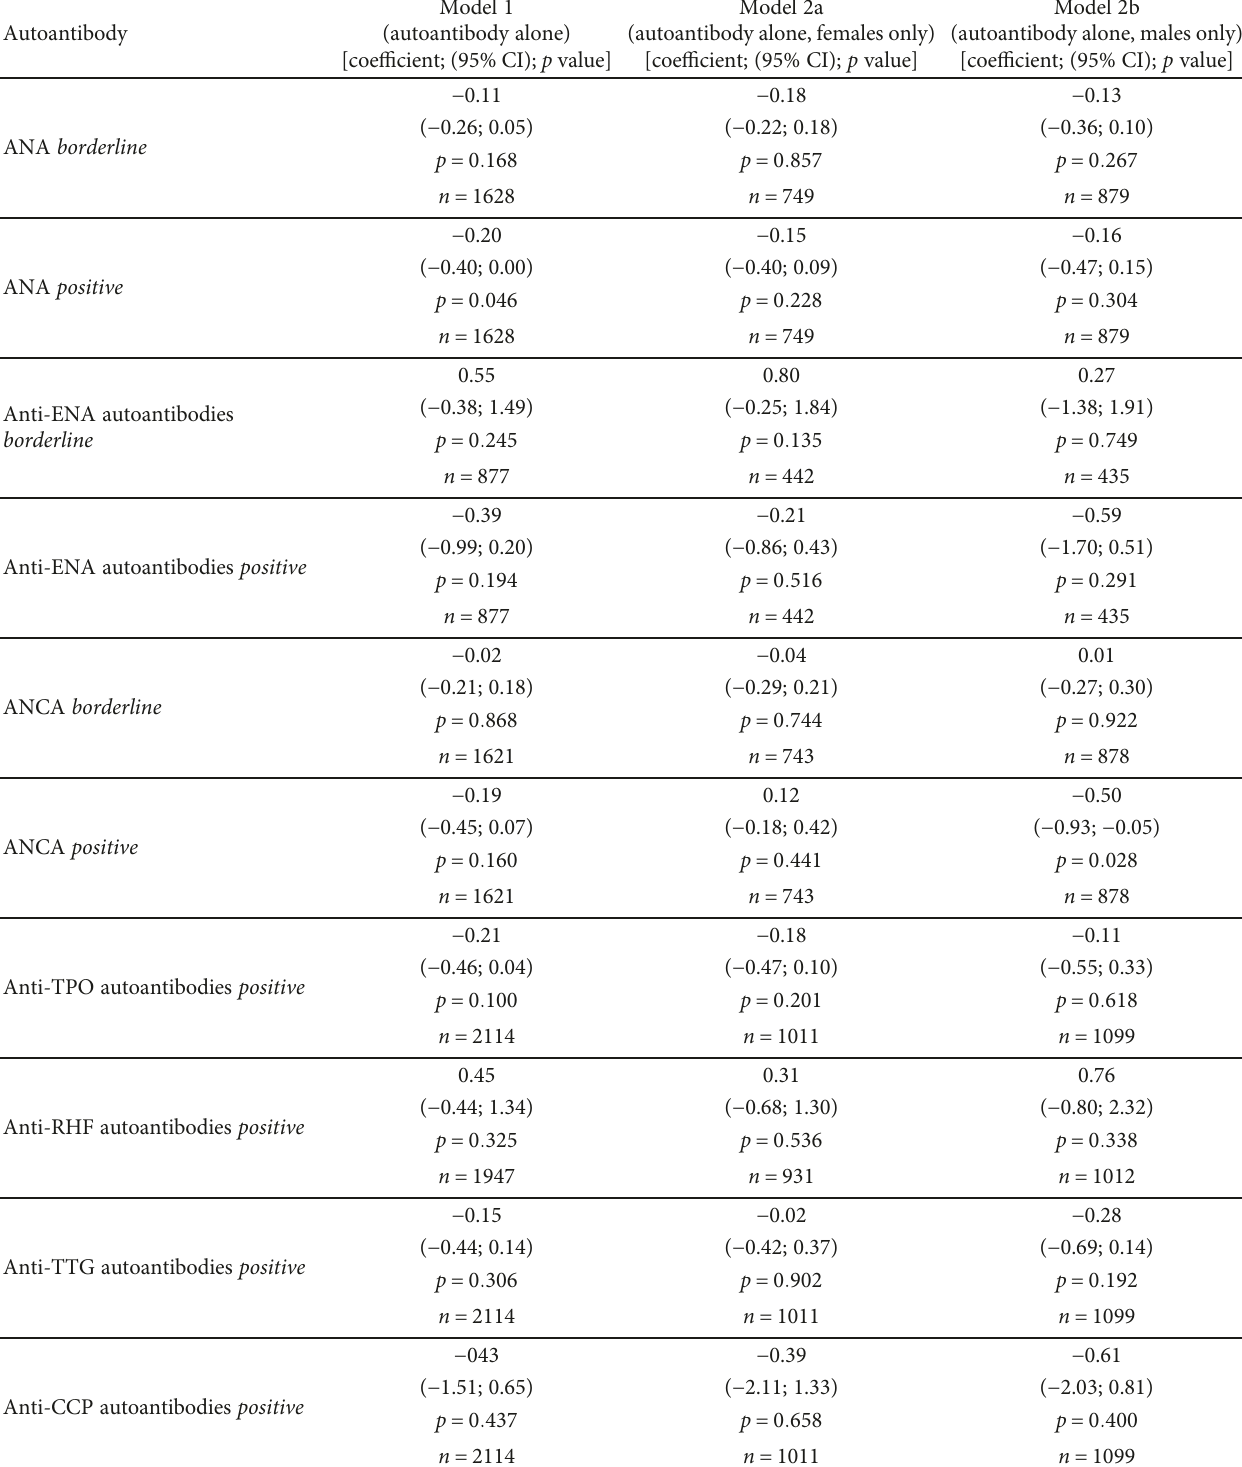
Table 7: Correlation between autoantibodies and quantitative ultrasound index (QUS index): univariate